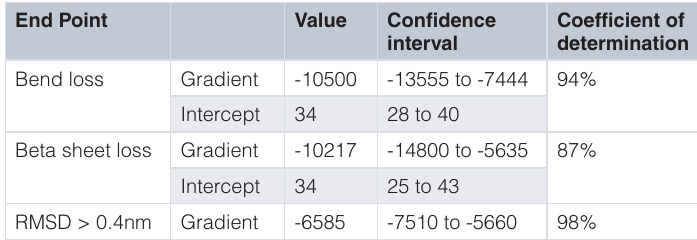
Table 5. Lines of best fit for the Arrhenius equation using the mean